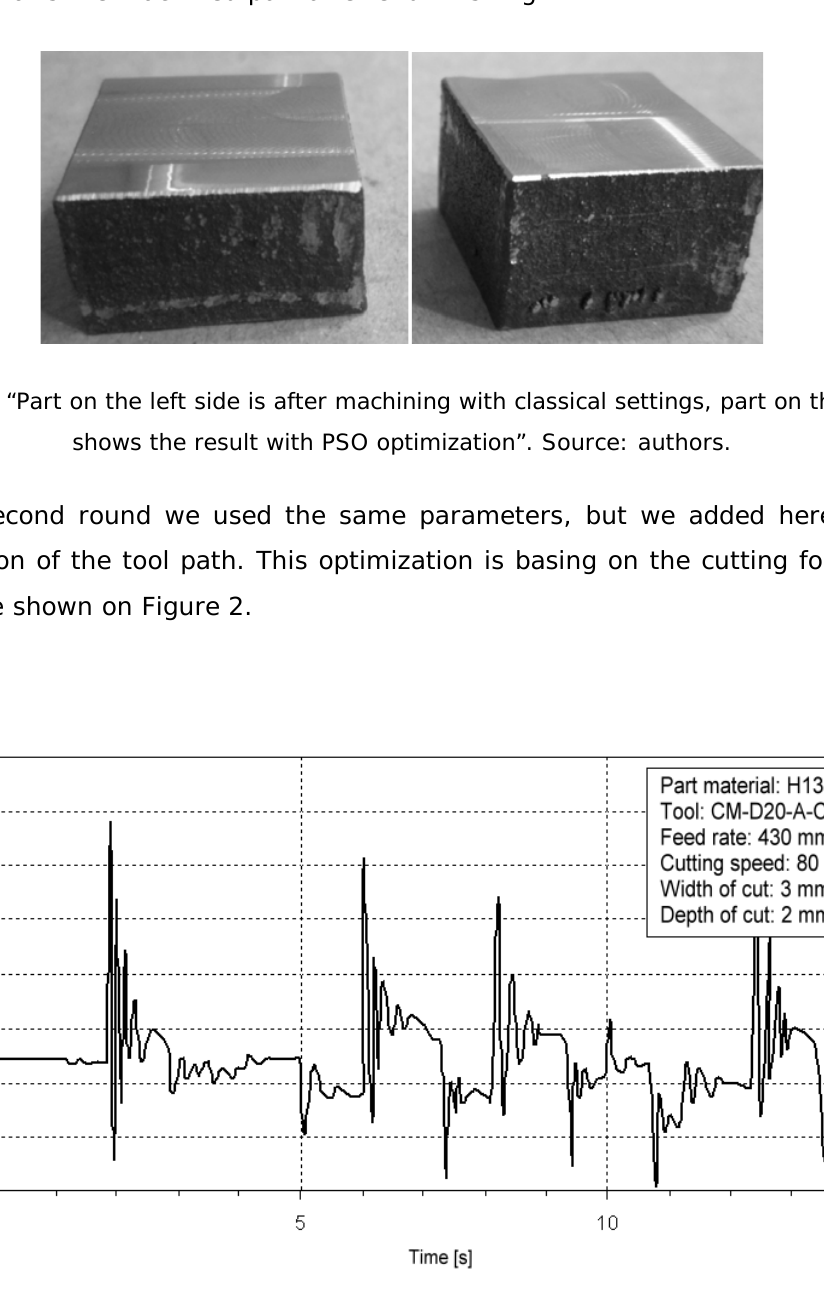
Figure 3. “Cutting force without the PSO optimization”. Source: